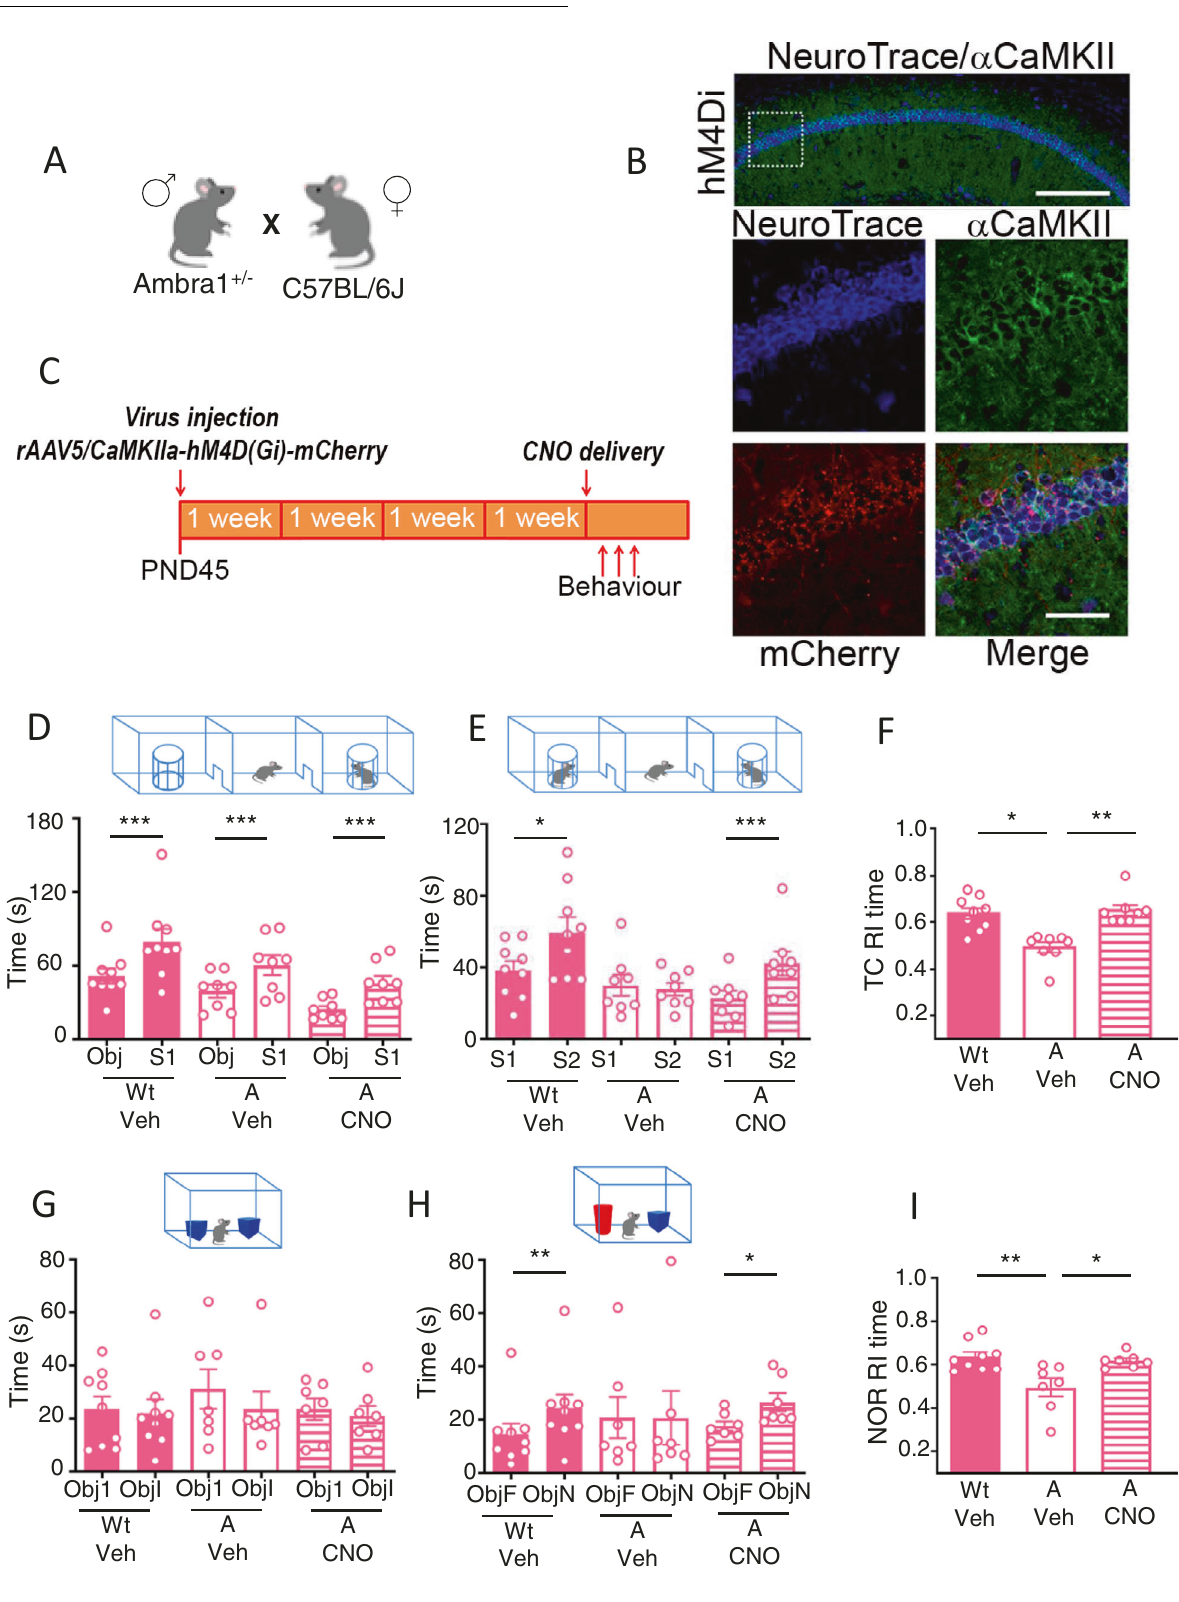
In the TC test, all groups spent more time in contact with the stranger female than with the object during the sociability phase (Fig. 3D). Group differences were found in the social novelty phase where Veh_A females failed to show social